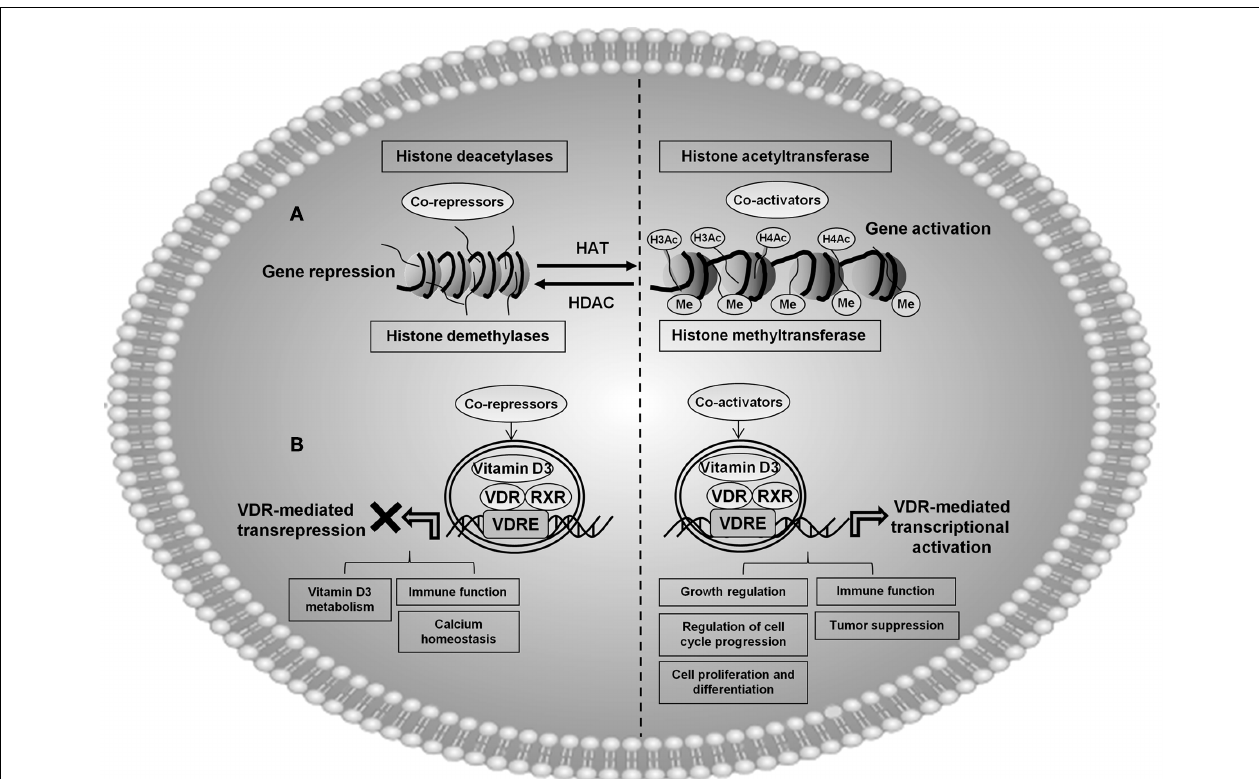
FIGURE 2 |A proposed model showing the possible involvement of vitamin D3 (1 α ,25-dihydroxyvitamin D3)-mediated molecular epigenetic mechanisms in regulation of cellular and physiological processes. (A) General mechanism showing acetylation and deacetylation of histone by chromatin modification. Histone acetylation correlates with active gene transcription, and deacetylation associated with gene repression. Demethylases along with HATs are involved in gene activation, whereas histone trimethylation is often associated with gene repression.Vitamin D/VDR deregulation can potentially lead to epigenetic chromatin modifications on histones H3 and H4, which may be associated with epigenetic modifications in chronic diseases linked with vitamin D deficiency. (B) Vitamin D receptor (VDR), exist as heterodimer with retinoid X receptor (RXR), and this complex (VDR/RXR) binds to specific genomic sequences on the promoter regions of target genes (vitamin D response elements), and recruits